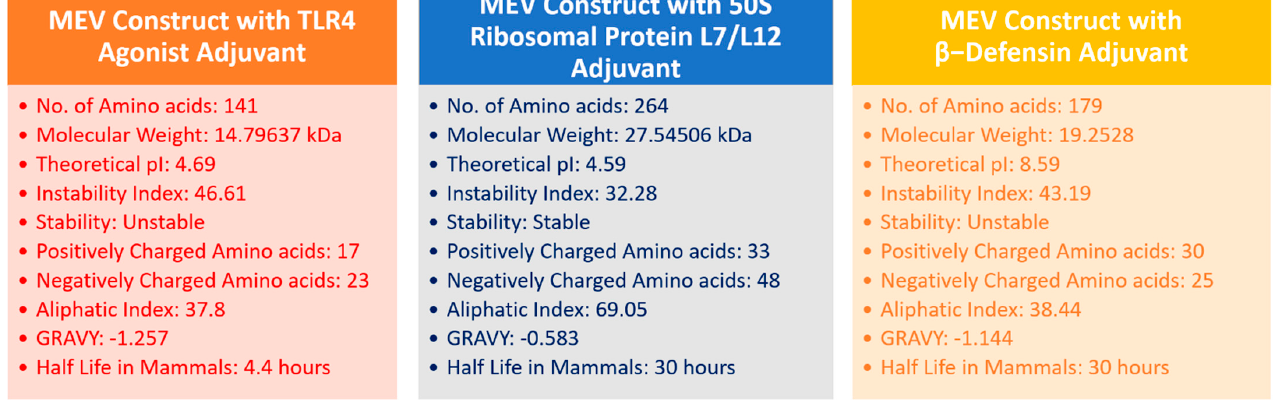
Figure 4. Physicochemical properties of three different MEV